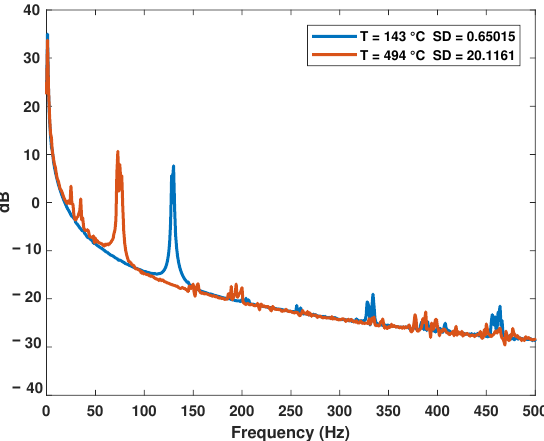
Figure 2. Average measurement of amplitude for runs 5 and 6.